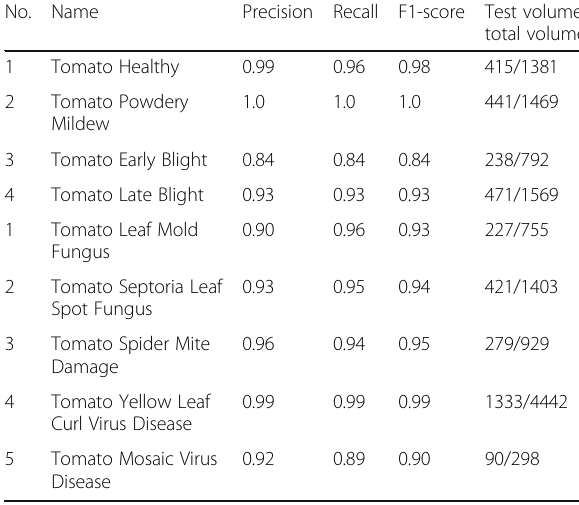
Table 4 Recognition results of